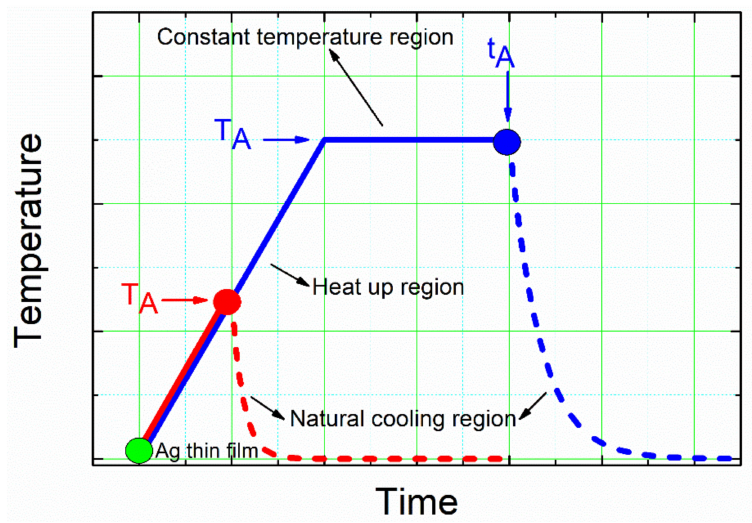
Figure 1. Schematic diagram of the temperature–time profile program employed for the annealing step of the solid-state dewetting process, where the different annealing and cooling to room tempera- ture regions are indicated. Red and blue areas were used to determine the effects of the annealing temperature (T A ) and the annealing time (t A ), respectively, on the morphological and structural properties of the resulting silver nanoparticles/glass substrate